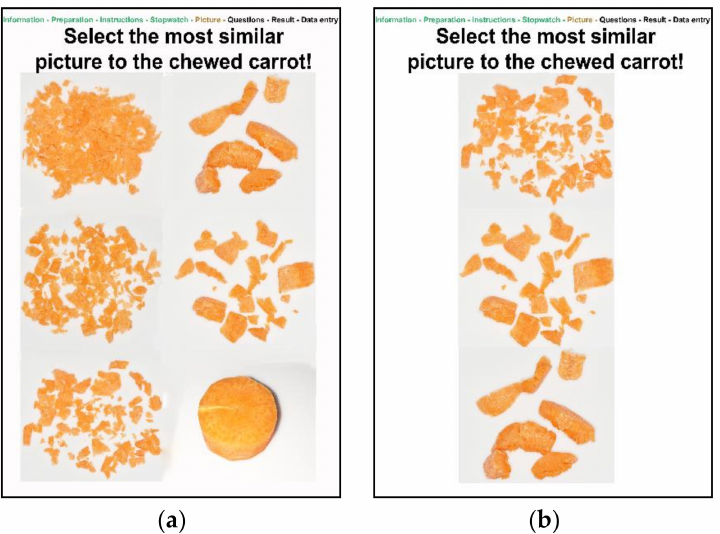
Figure 3. Screenshot of the digital MDA control questions with two-step decision making; ( a ) carrots of different degrees of comminution; ( b ) carrots of different degrees of